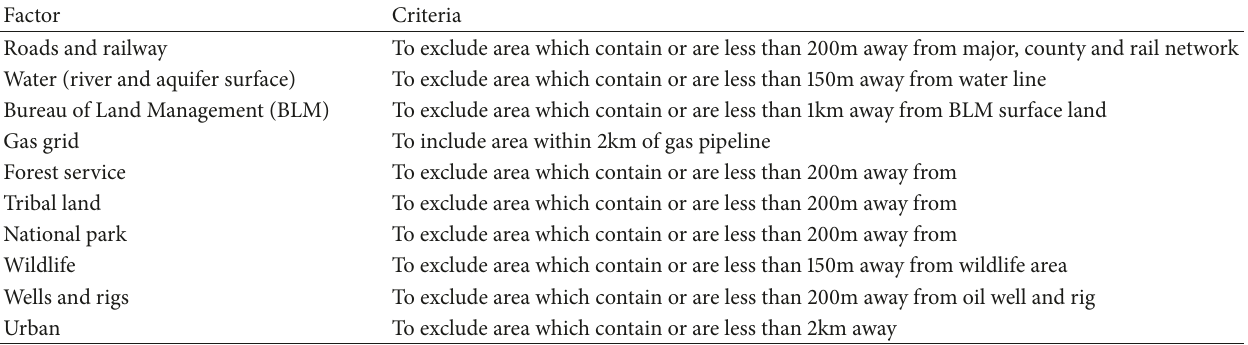
Figure 1: Geographic distribution of animal manure feedstock resource and potential biogas plants in North Dakota. Table 2: Factor and criteria to select candidate biogas